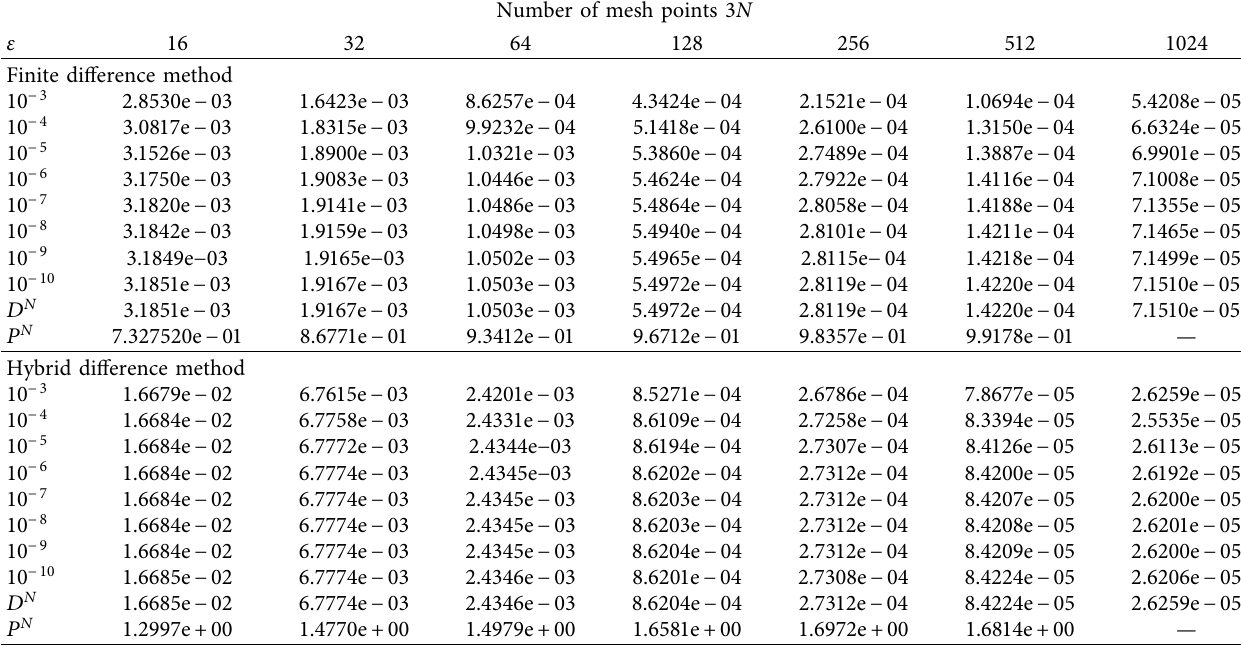
Table 1: Computed P N rate of convergence and D N maximum errors for Example 1.